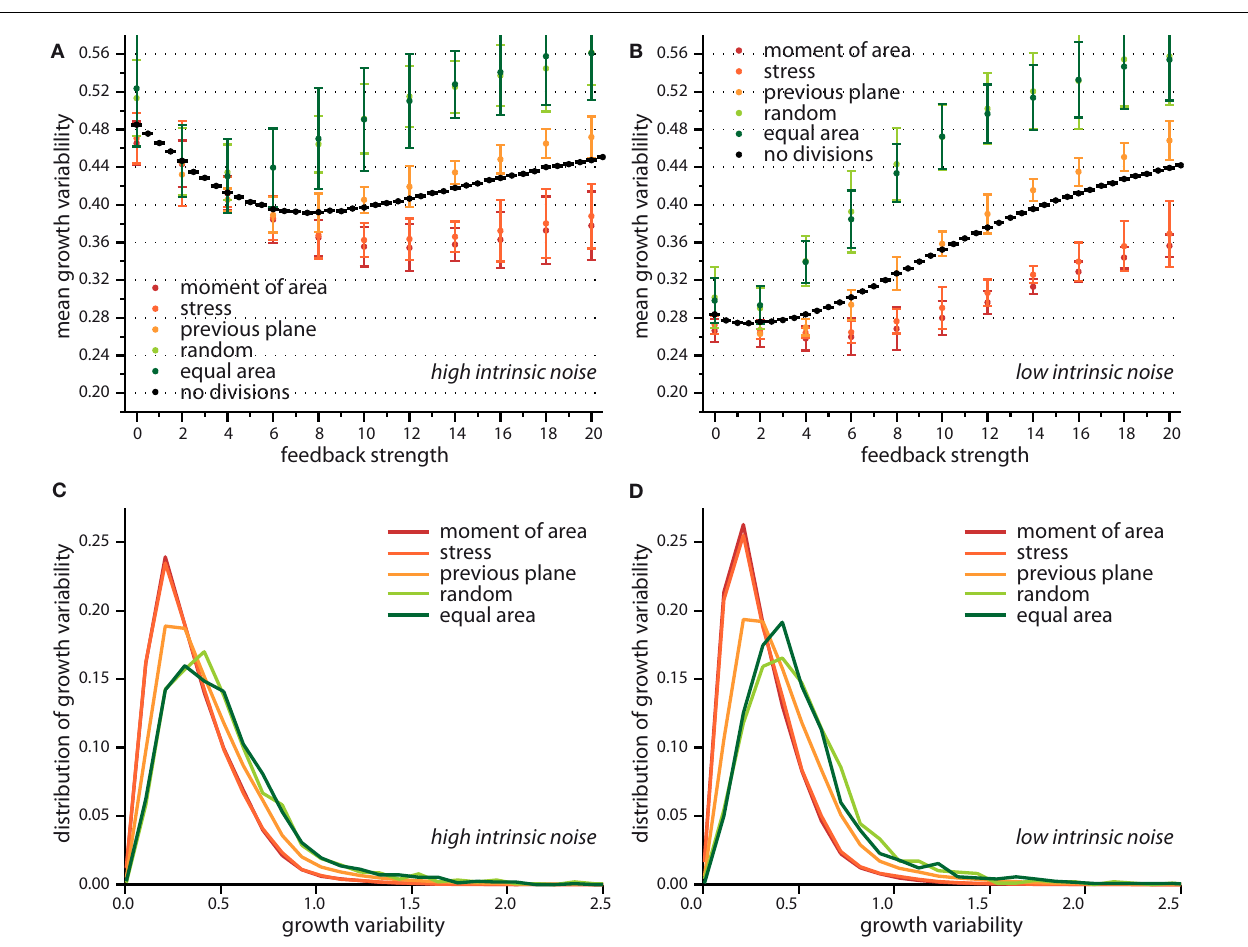
no cell divisions. Cell divisions with high noise on the other hand, where cells divide along a random direction, or randomly but ensuring equal areas counteract the effect of stress feedback yielding higher growth variability.The case where the cell division plane is perpendicular to the previous divisions plane interpolated between those two limiting cases. Distribution of growth variability is significantly broader at high noise, however differences between cell division modes are